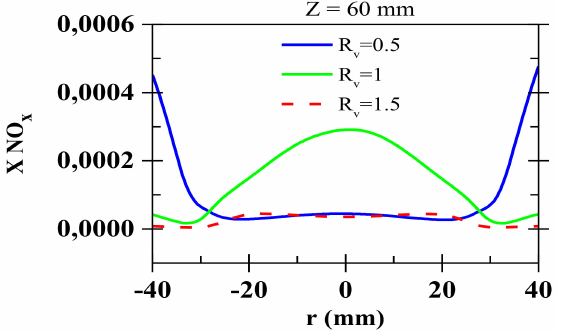
Figure 15. Radial profiles of NOx mole fractions obtained for different velocity ratios at Z =